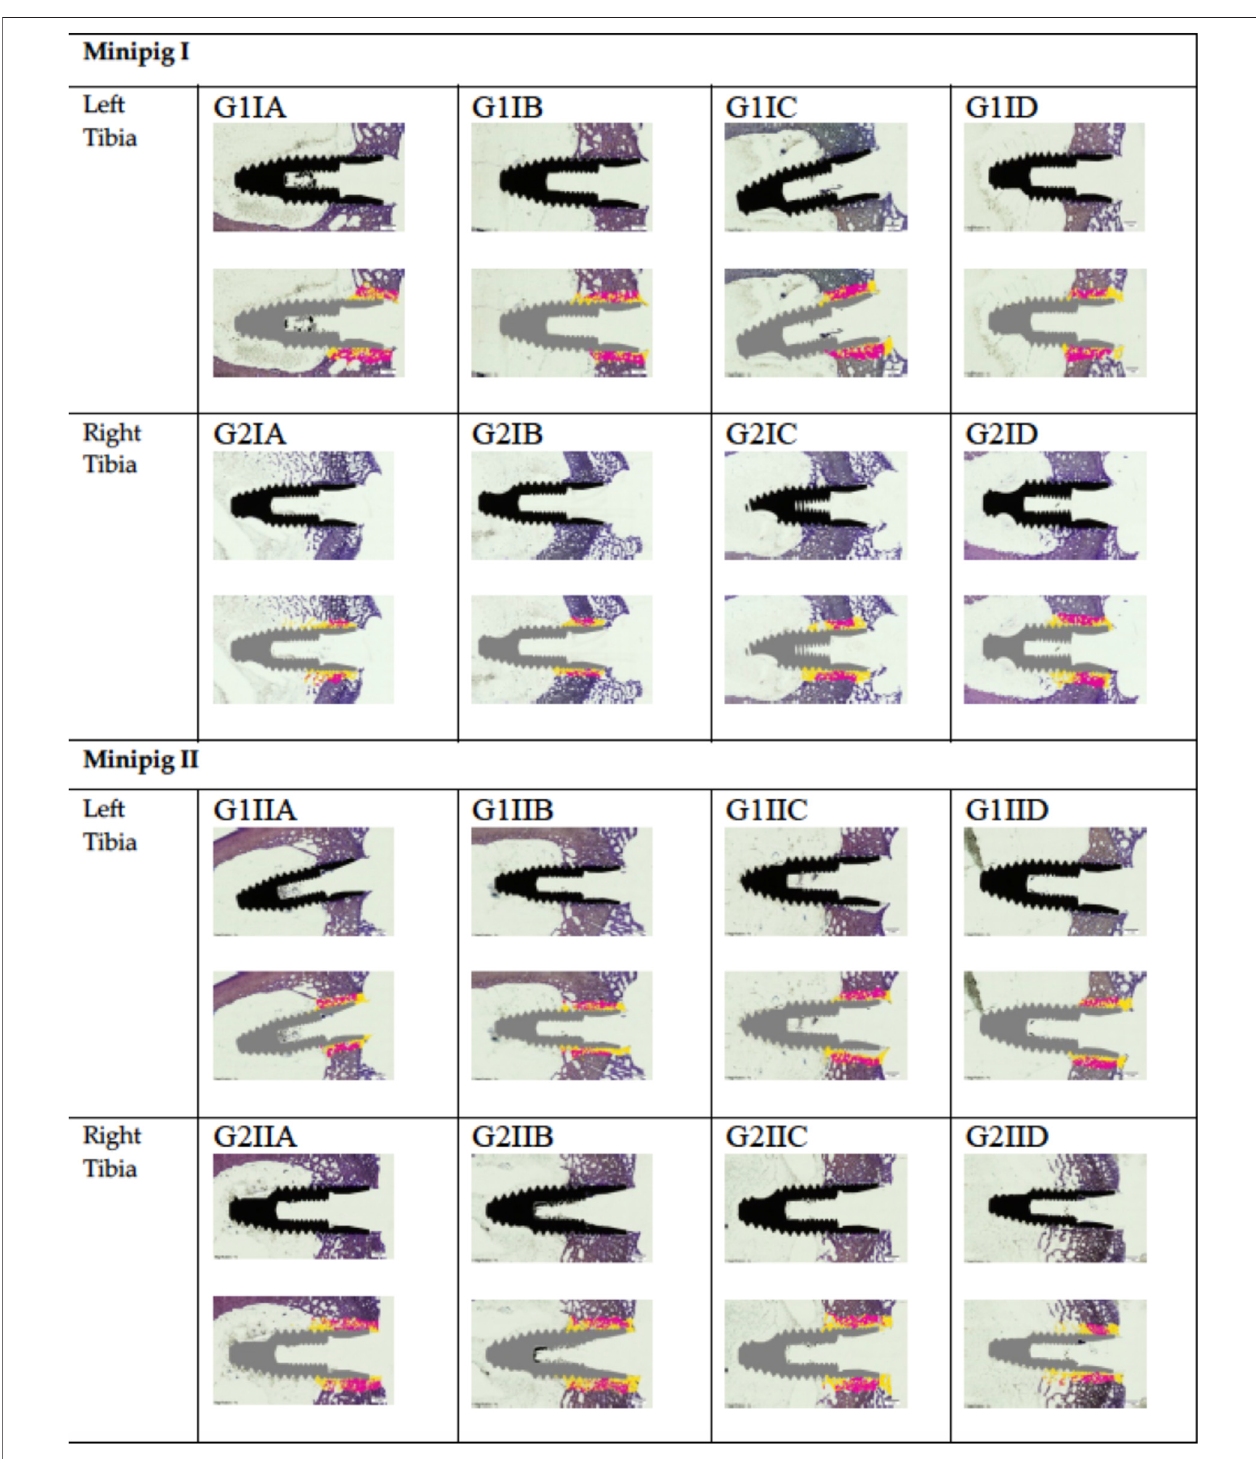
FIGURE 7 | Images of histomorphometric sections ofall implants in the study in groups G1 and G2. (A) and (B) represent the osteotomies with the least and most proximitytotheabdomen,respectively,and (C) and (D) theosteotomieswiththeleastandmostproximitytothehoof,respectively.The fi rstimageshowsthelongitudinal sectionofthespecimen,beforecomputerprocessing;thesecondimageshowsthephotoshop-processedlongitudinalsectionwiththeimplantsingrayandtheareasof old bone (pink), areas of new bone (yellow) and areas of soft tissue (white).